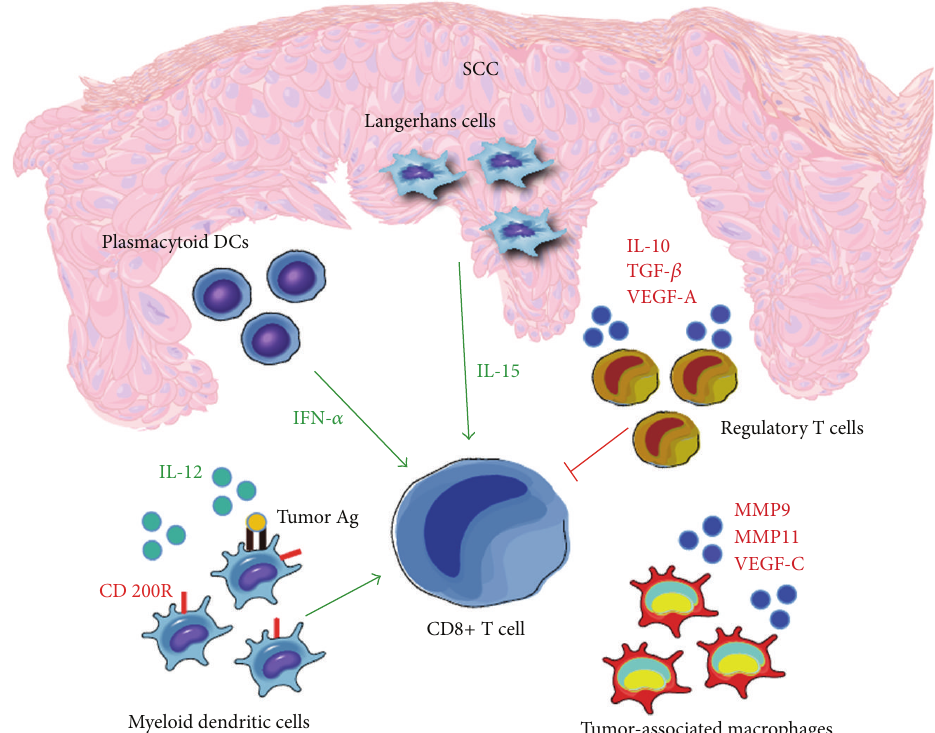
Figure 4: The SCC microenvironment may impact the immune response. The SCC microenvironment is dynamic and involves a complex interplay of both pro- and anti-inflammatory signals. It is associated with an elevated number of IFN- 𝛼 secreting pDCs, and an increased capacity for LCs to stimulate CD8+ T cells. These may serve to enhance the immune response and promote tumor immunity. Conversely, we have also shown the tumor microenvironment to contain an increased number of regulatory T cells, tumor-associated macrophages, and immune suppressive molecules such as IL-10, TGF- 𝛽 , and VEGF-A. These may be contributing to tumor growth and immune dysfunction through the suppression of mDC and CD8+ T cell